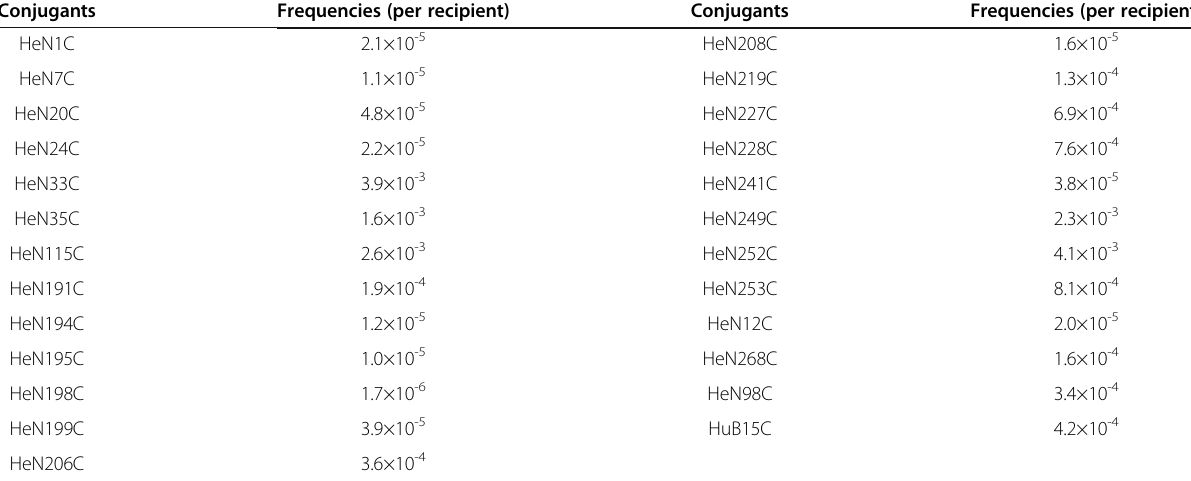
Table 2 Conjugation frequencies of mcr -carrying plasmids Conjugants Frequencies (per recipient) Conjugants Frequencies (per